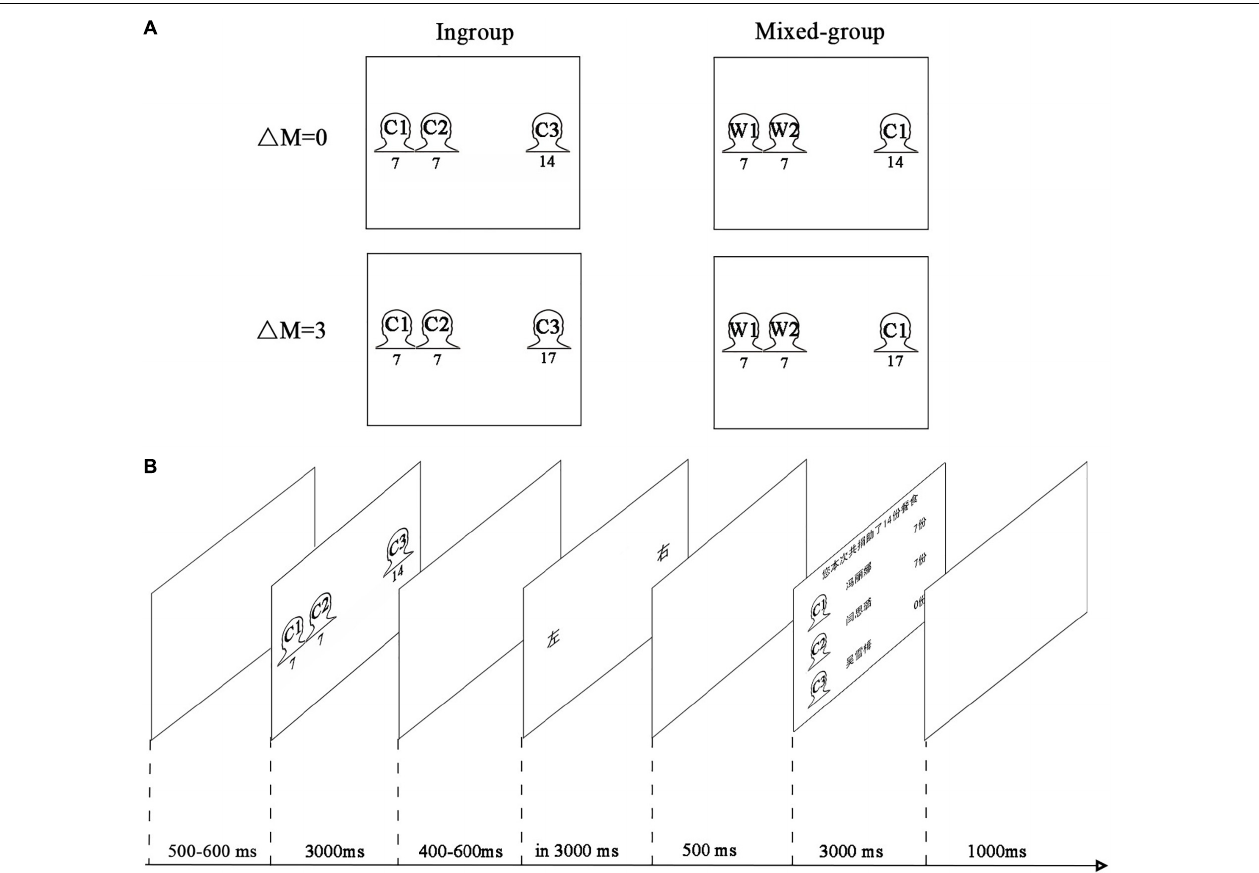
FIGURE 1 | Experimental paradigm. (A) We presented four (2 × 2) kinds of stimuli. The first factor referred to ingroup type (ingroup: two Chinese children and one Chinese child; mixed-group: two Western children and one Chinese child). The second factor referred to efficiency difference between two options ( (cid:49) M = 0 meals vs. (cid:49) M = 3 meal). Indicative instead of original images of children used here for a demonstration purpose (C represented Chinese child; W represented Western child). (B) Timeline of screens within a trial.